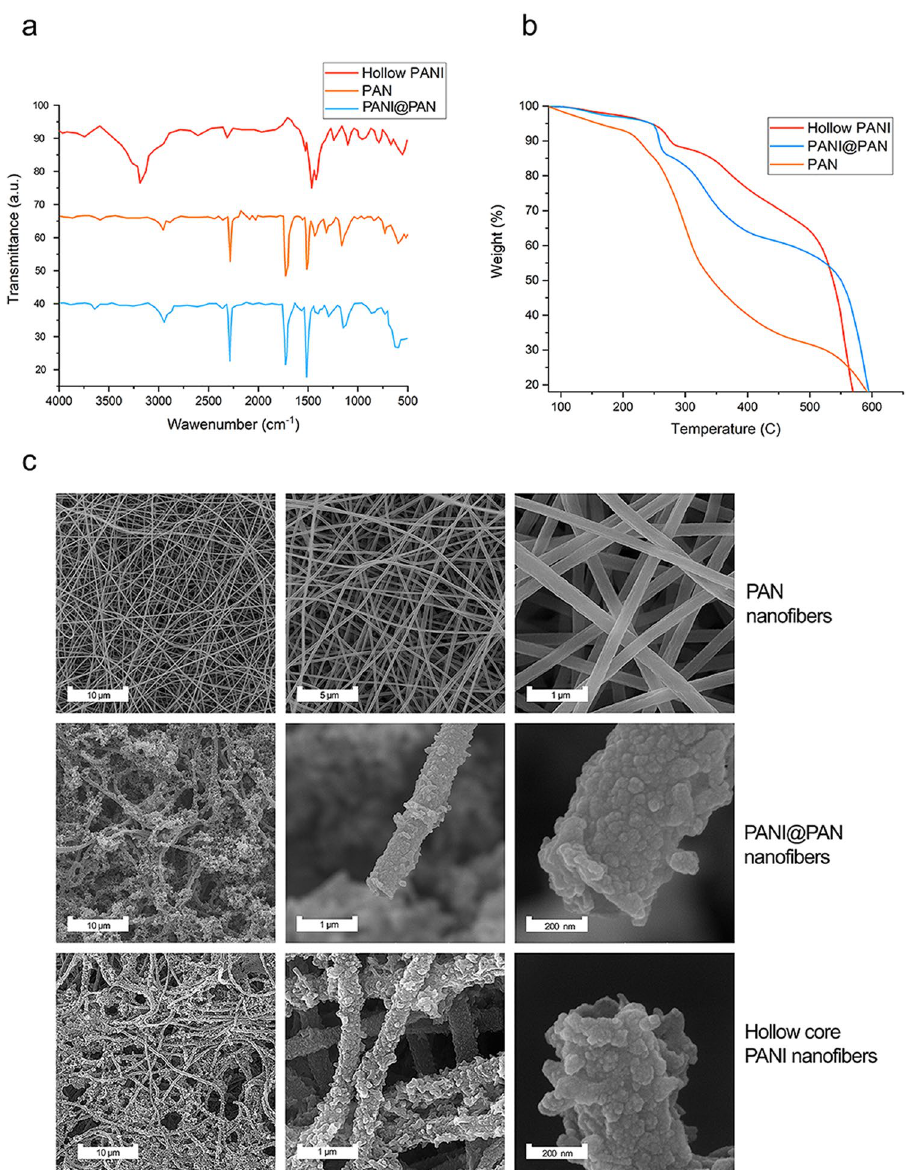
Figure 3. Morphological, structural, and thermal features of the fabricated electrospun nanofibers. ( a ) ATR- FTIR spectra of hollow PANI, PAN, and PANI@PAN. Lack of an absorption peak at 2243 cm −1 in the hollow PANI sample implies that there is no PAN on the surface of the hollow nanofibers; ( b ) TGA gravimeters to investigate the PAN removal procedure as a sacrificial template; ( c ) FE-SEM tests conducted on nanofibers of PAN, PANI@PAN and hollow core PANI. The cross-sections of the hollow nanofibers clearly show their